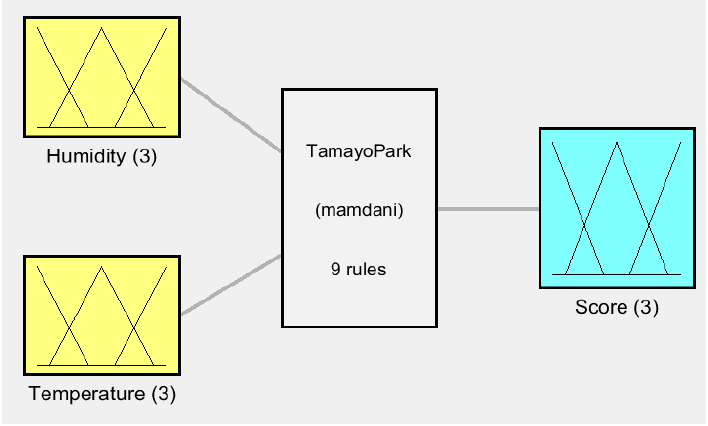
Figure 2. Fuzzy inference system.